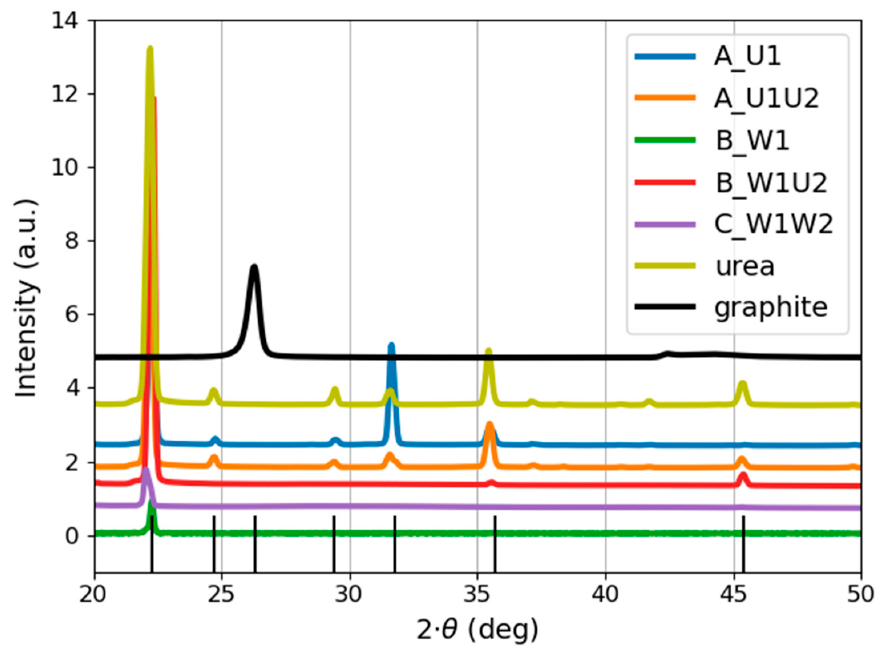
Figure 6. Diffraction patterns of the carbon nanostructures, reference sample (urea solution), and graphite target. The B_W1 signal was multiplied by 10. Peak positions are indicated by black vertical lines.